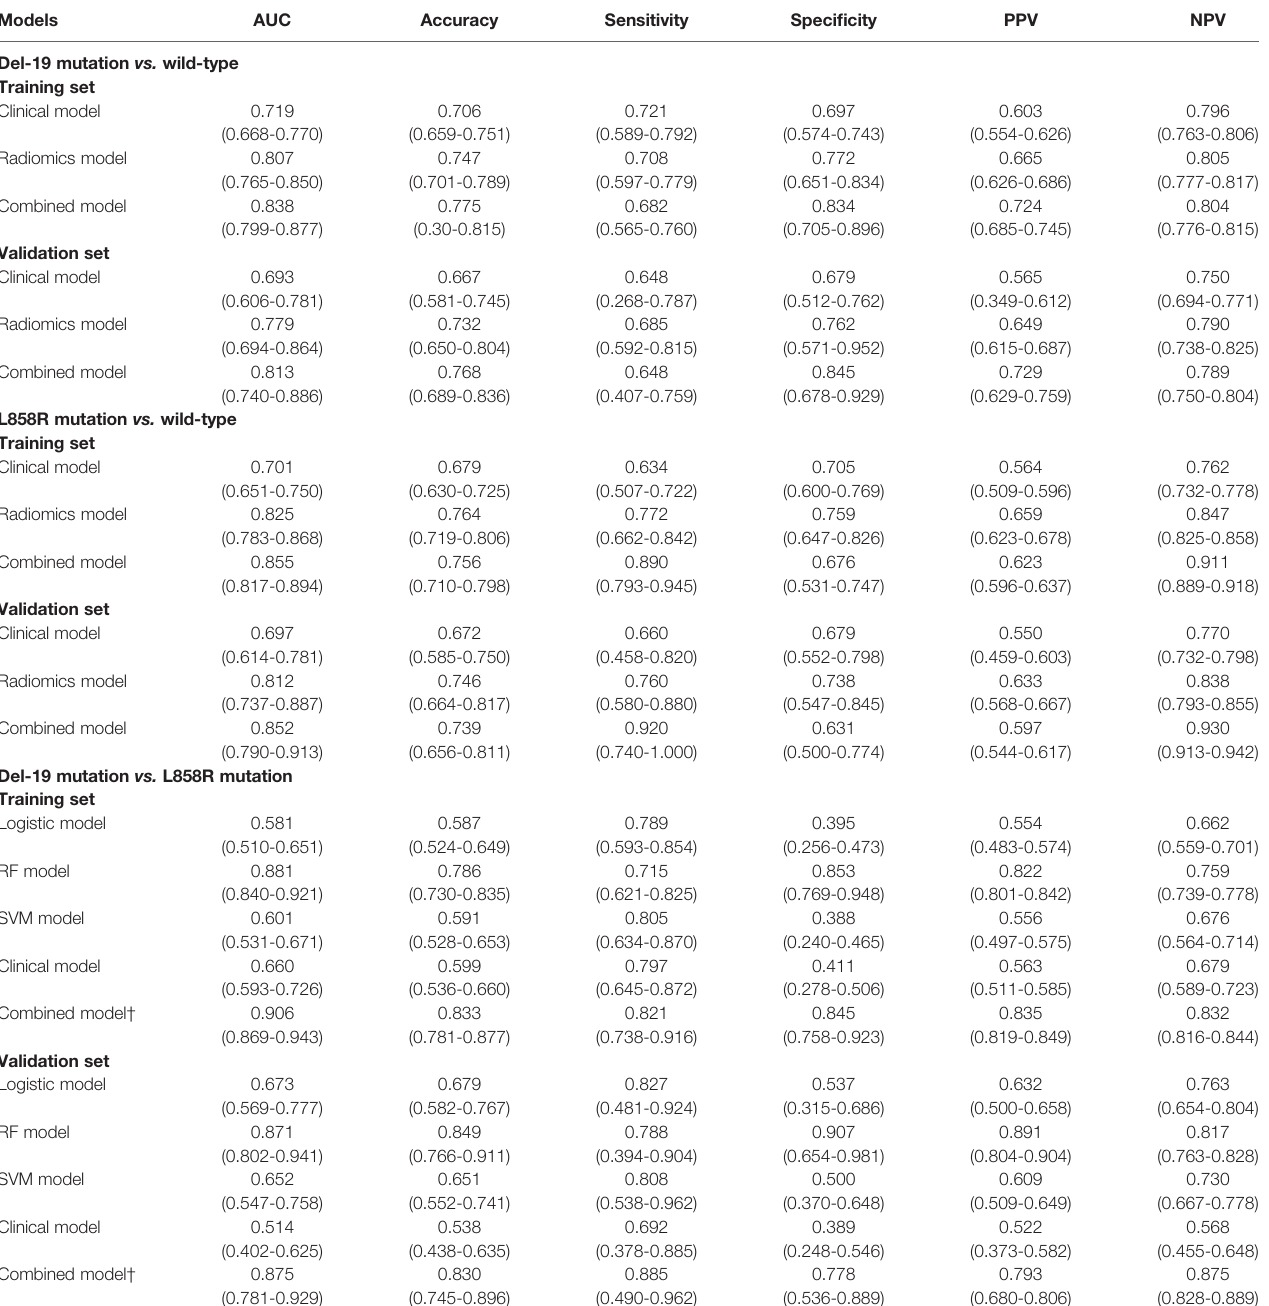
TABLE 4 | The prediction performance of different models in the training and validation